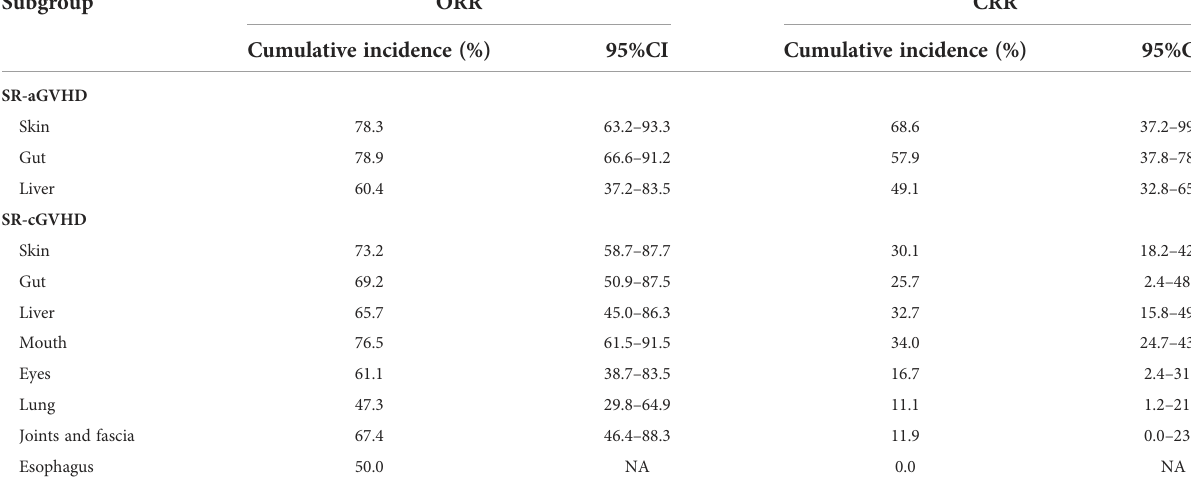
TABLE 7 Response at any time according to the involved organs after ruxolitinib